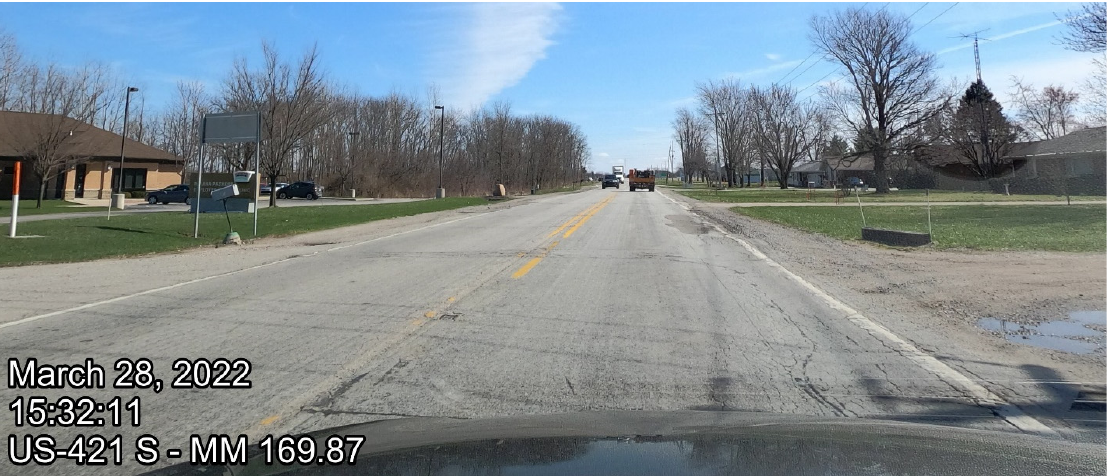
Figure 2. US-421 pavement condition in Delphi,